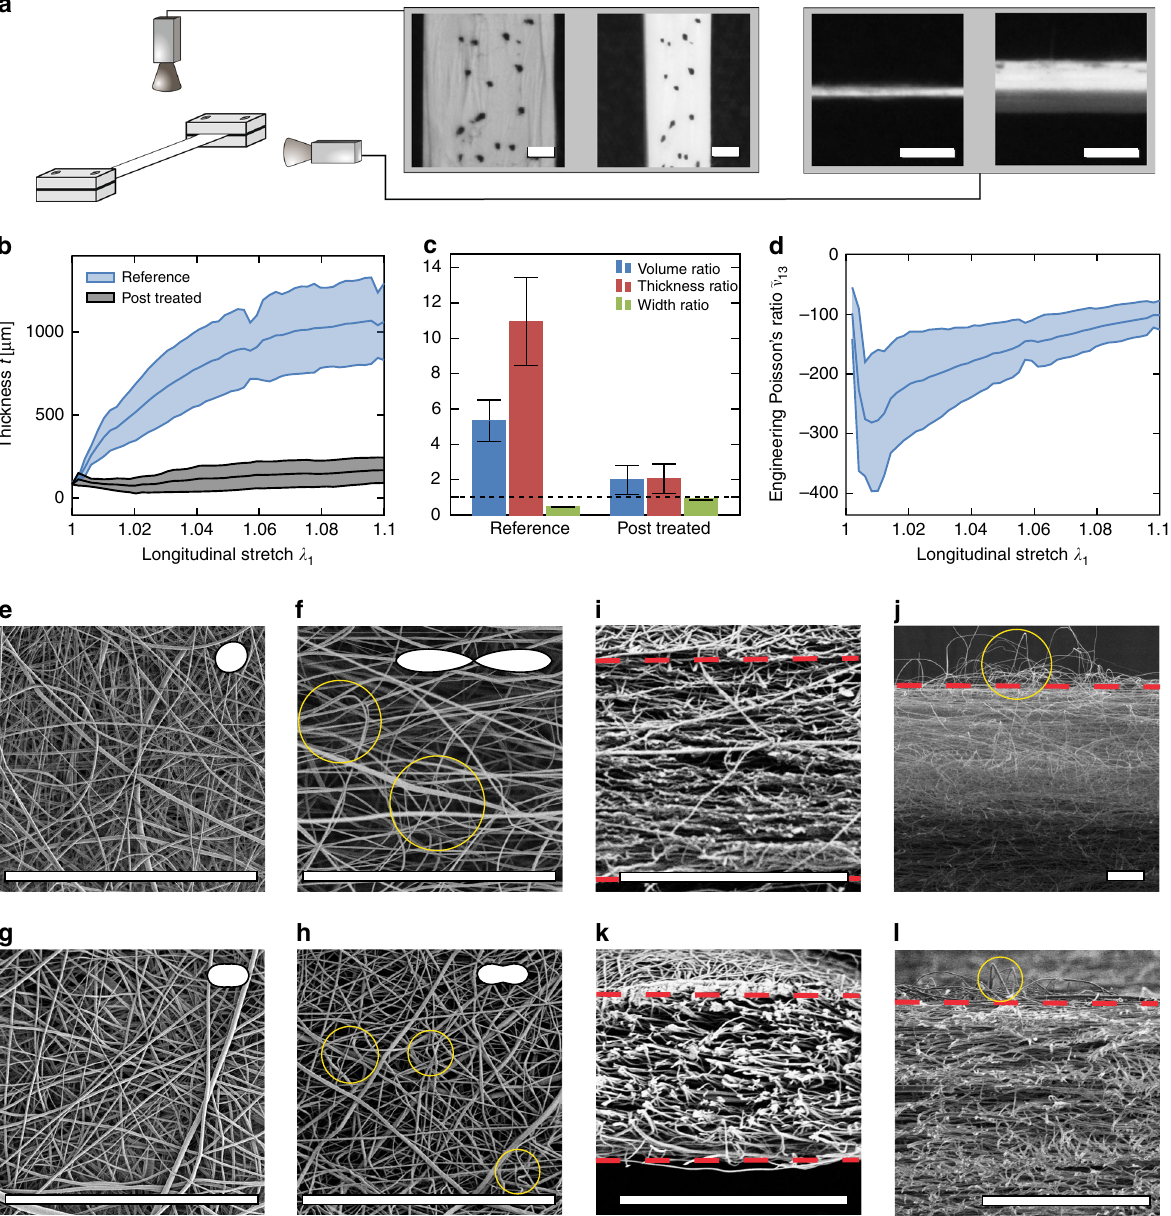
Fig. 2 Auxetic electrospun networks. a Sketch of the experimental set up with representative pictures of the top and side camera at 0% strain and at a stretched state. Scale bar: 2 mm. b Diagram showing the evolution of the thickness for applied strain λ 1 of the reference and post-treated networks. c Ratios of volume, thickness and width between 10 and 0% strain show signi fi cant differences between reference and post-treated mats ( p < 0.01,